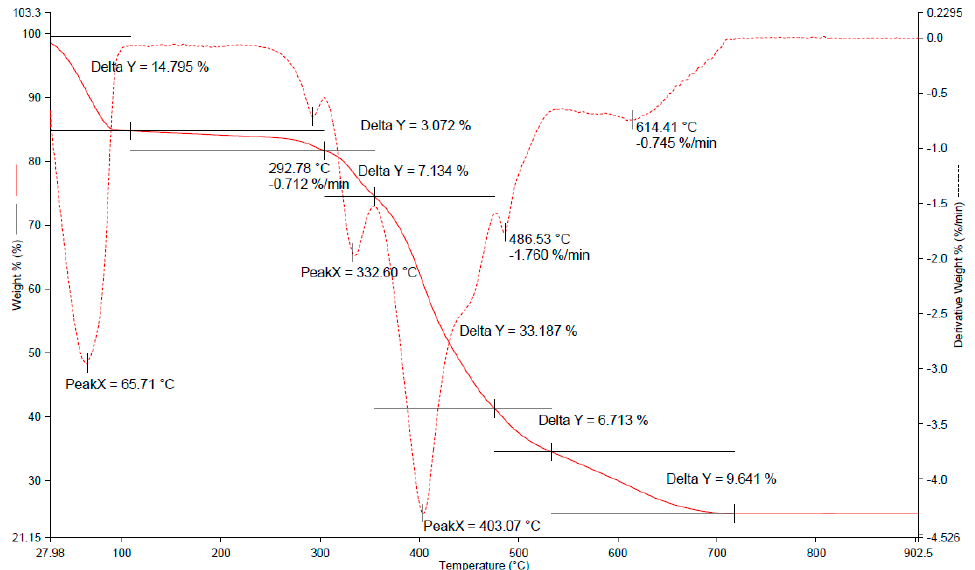
Figure 3. Thermogravimetric curves determined for samples of silica coatings containing ionic liquid IL-2.